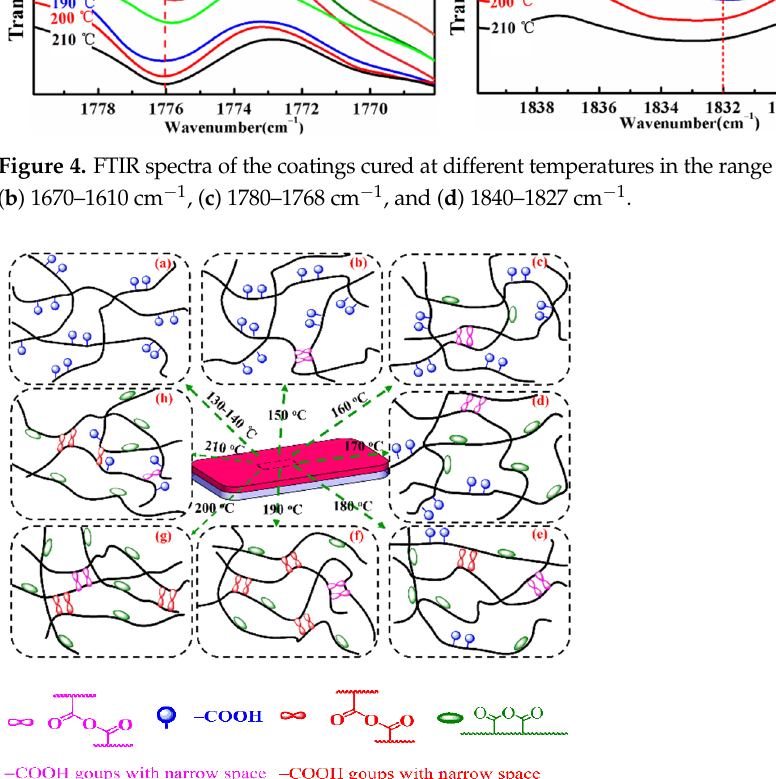
Figure 4. FTIR spectra of the coatings cured at different temperatures in the range of ( a ) 3600–600 cm − 1 , ( b ) 1670–1610 cm − 1 , ( c ) 1780–1768 cm − 1 , and ( d ) 1840–1827 cm − 1 .